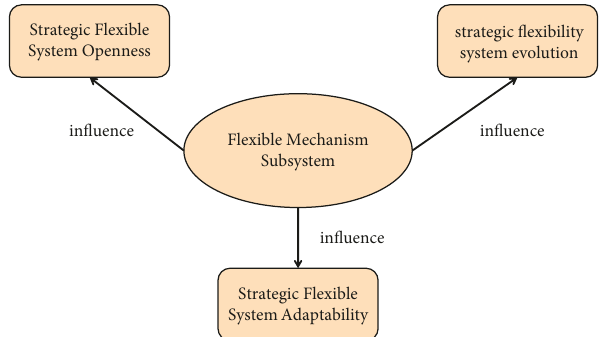
Figure 5: Influence of flexible mechanism subsystem on the strategic flexible